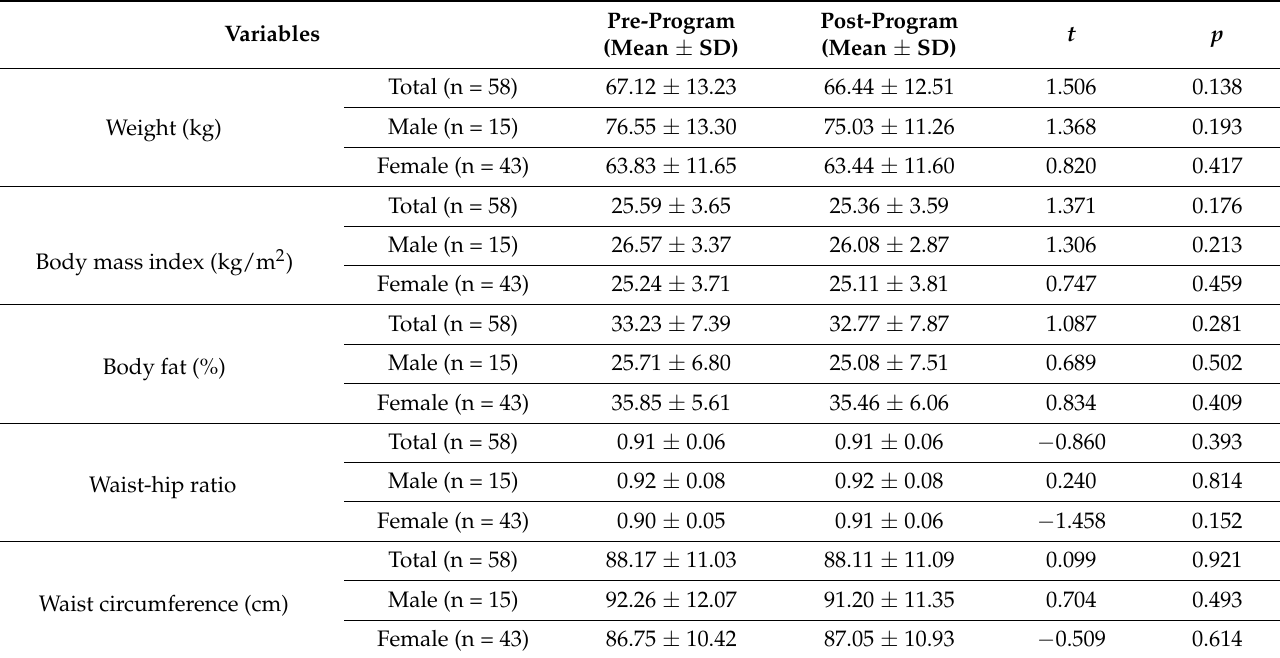
Table 3. Changes in anthropometric characteristic variables after 24 weeks of non-face-to-face